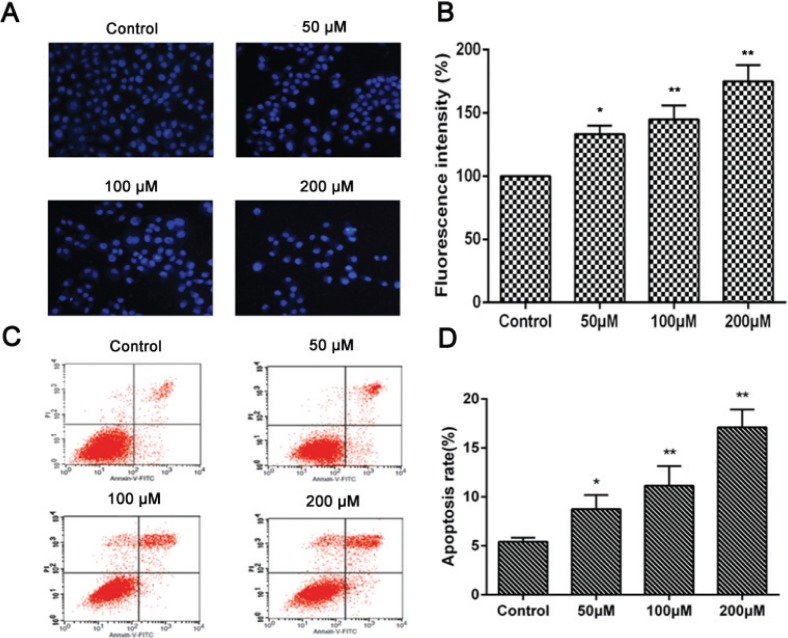
Induction of apoptosis in MCF-7 cells with Nobiletin.(A) Fluorescence images and (B) fluorescence intensity of MCF-7 cells subjected to Hoechst 33258 staining of nuclei following treatment with various concentrations of Nobiletin for 24 h (magnification, ×20) (C) Flow cytometry and (D) percentage of apoptotic cells examined by Annexin V-FITC and PI assay following treatment with various concentrations of Nobiletin for 24 h. Data represented as mean ± SD of three independent experiments. *p < 0.05 compared with control cells. **p < 0.01 compared with their respective control cells.